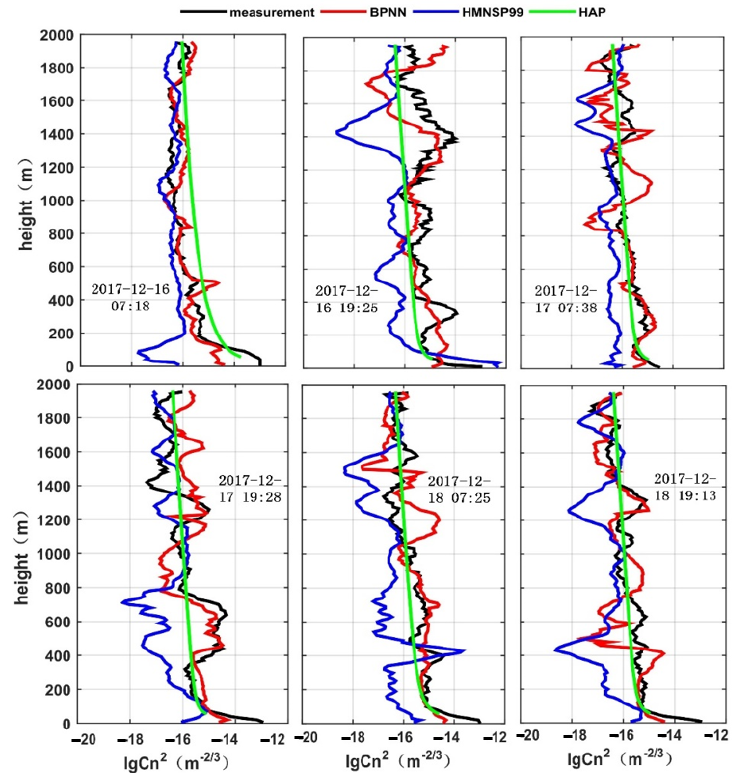
Figure 4. Vertical profiles of C 2 n from the radiosonde, BP neural network, HMNSP99 model and HAP model.